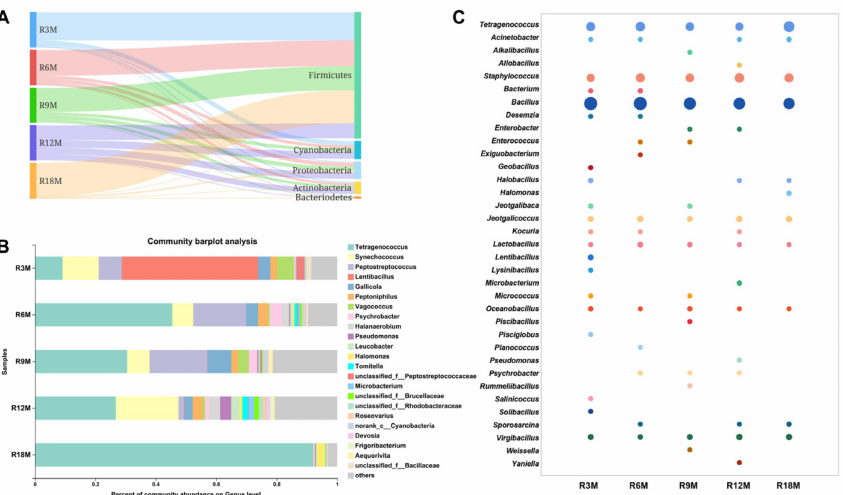
Figure 2. Analysis of bacterial community dynamics in the fish sauce fermentation process. ( A ) Bacterial community dynamics at the phylum level. ( B ) Bacterial community dynamics at the genus level. ( C ) Bacterial community dynamics analysis by traditional separation and screening methods. (R3M, R6M, R9M, R12M, R18M indicated for 3, 6, 9, 12, 18 months,